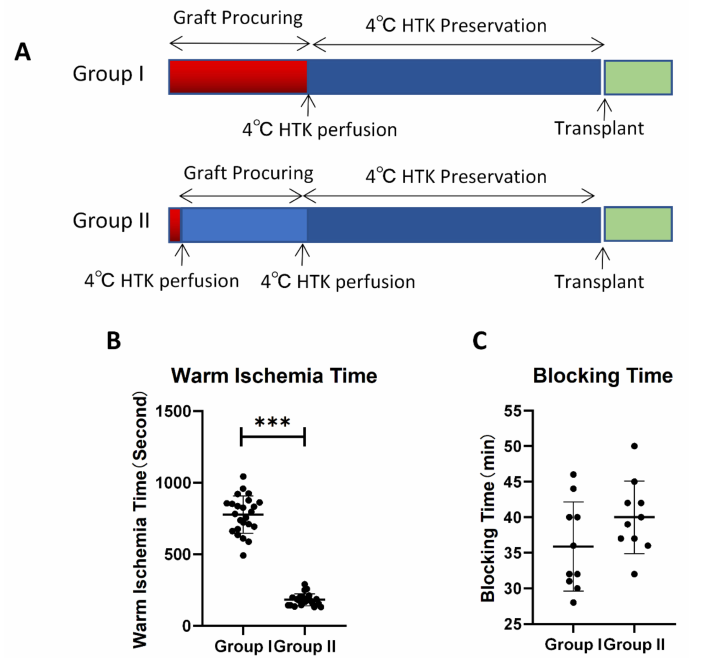
Figure 1. Overall evaluation of two surgical procedures. Schematic surgery process: ( A ) of two groups. Blocking time warm-ischemic time; and ( B ) blocking time ( C ) of two groups (( B ): n = 23, ( C ): n = 10, *** p <